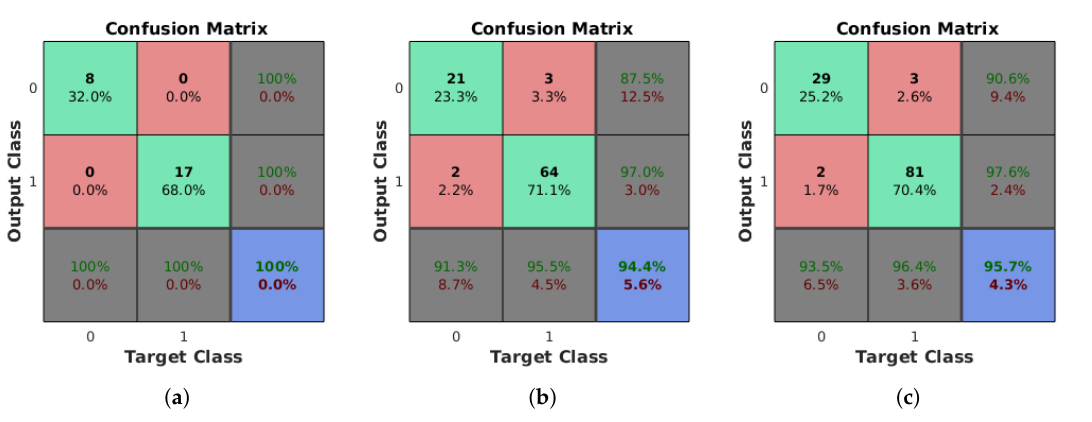
Figure 12. Confusion matrices for the ON/OFF state of the lamps for the different types. Class 0: turned off; Class 1: turned on. Overall, 100% of the rectangular lamps were correctly classified, while 5.6% of the circular lamps were assigned to the wrong class. The correct state was given for a total of 95.7% of the lamps of both models: ( a ) rectangular lamps; ( b ) circular lamps; and ( c ) all lamps.